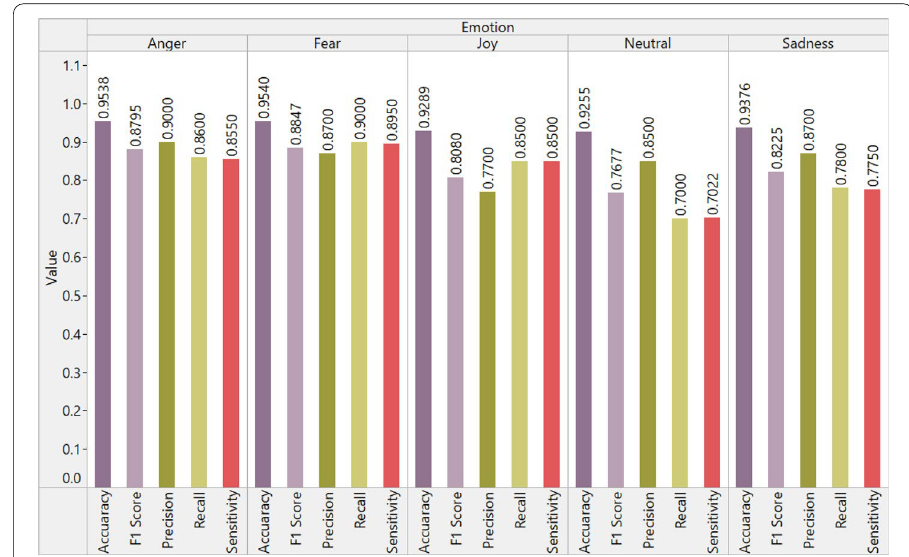
Fig. 22 Performance evaluation of test set using BERT model (Micro level)